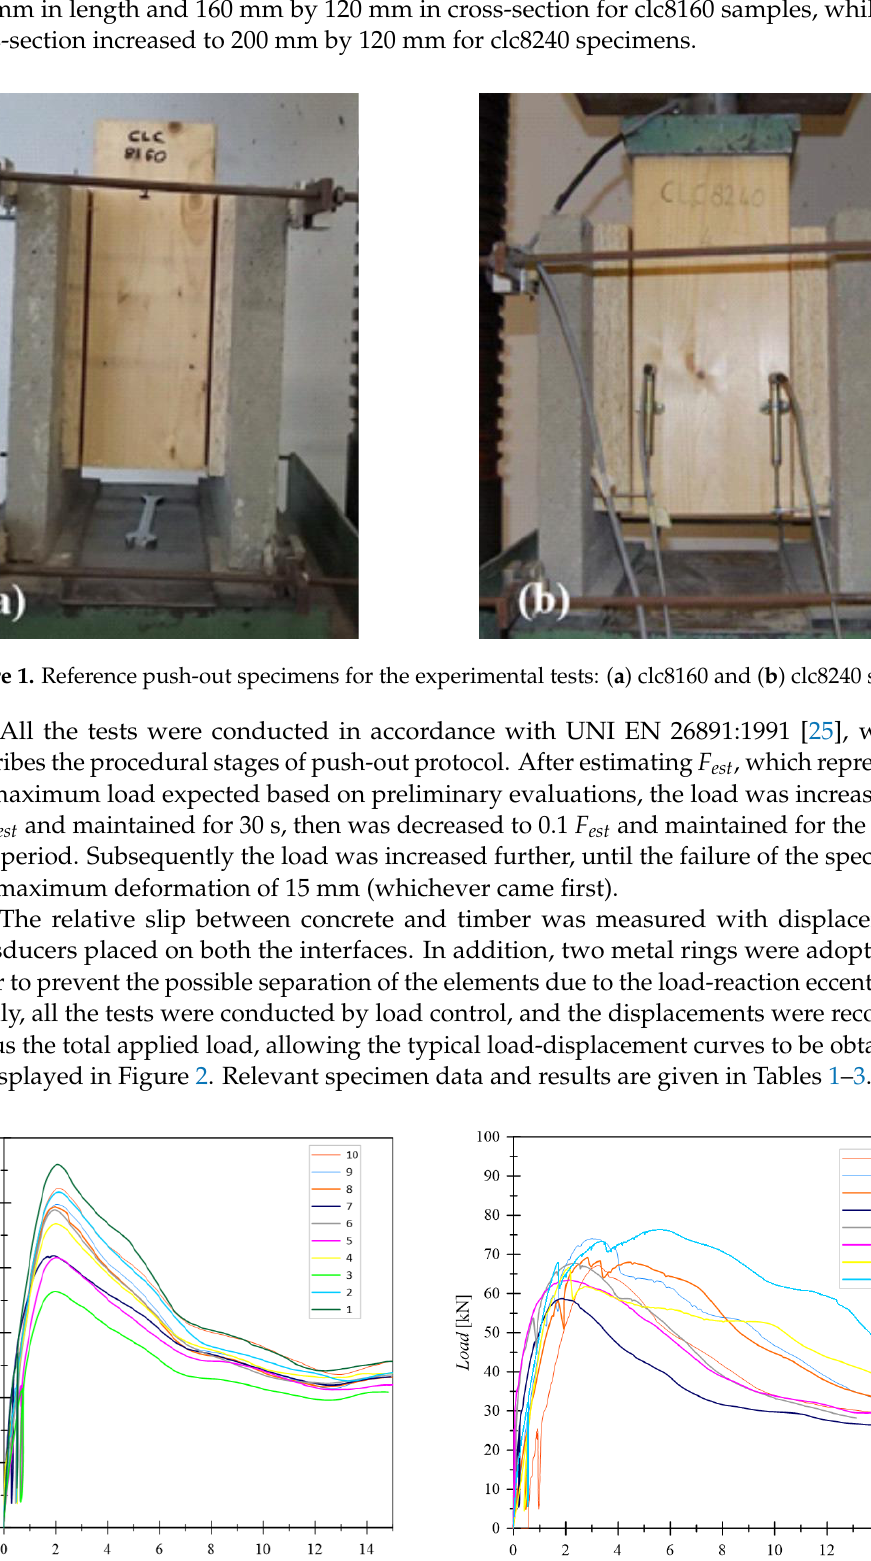
Figure 2. Experimental load-displacement curves for ( a ) clc8160 and ( b ) clc8240 specimens.